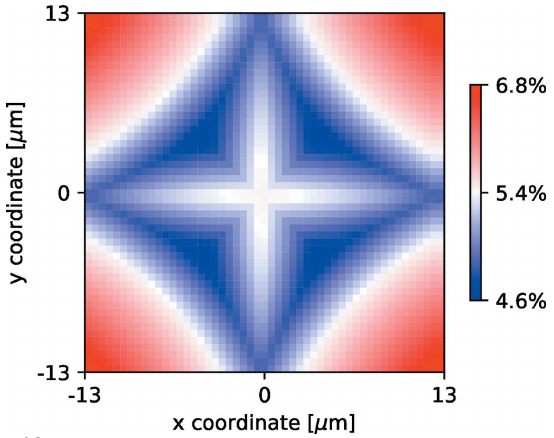
Figure 10 A map of the fraction of light collected ( S pixel ) depending on the X-rays interaction point for a 29 m m-thick GOS:Tb screen and a pixel size of 26 m m. Over the pixel area, the average fraction of light collected is 5.4%, whereas the minimum fraction of signal collected ( (cid:8) min ) is 4.6%. The center of the pixel is located at [0,0].